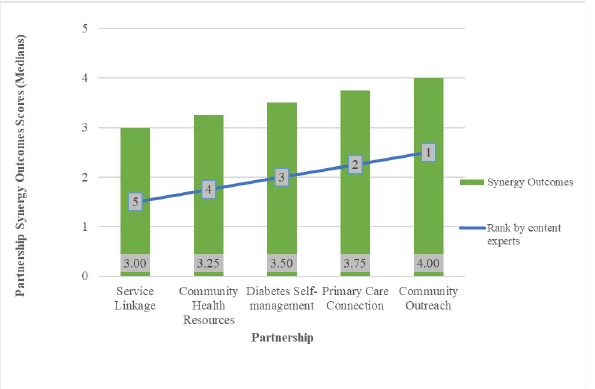
Fig 1. Partnership synergy outcomes (partnership-level median scores) and rankings of partnerships based on assessment by content reviewers (highest = 1 to lowest = 5) ( N = 5 ).